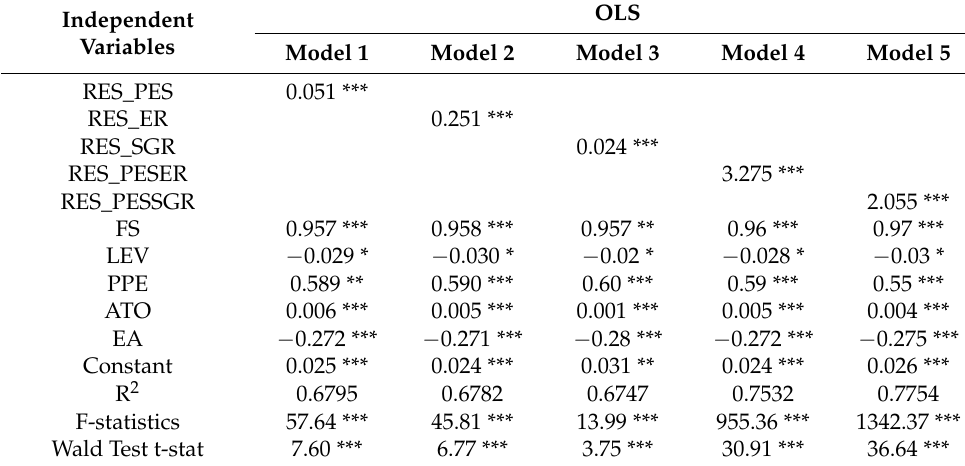
Table 1. Endogeneity